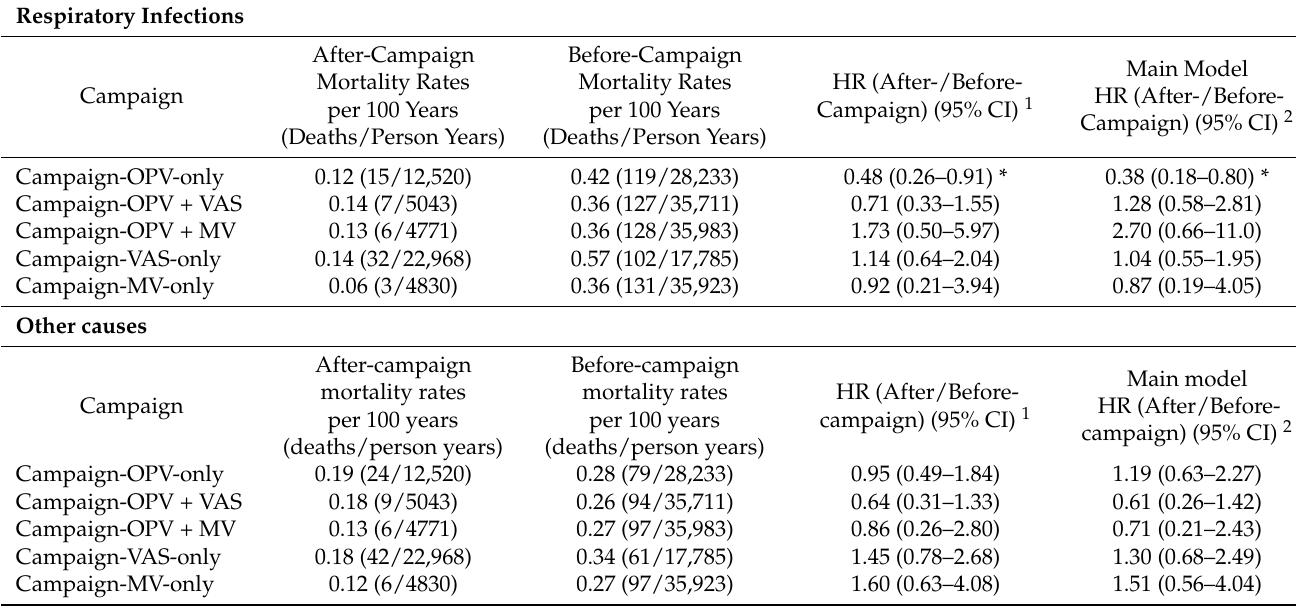
Table 1. Mortality rates (per 100 person-years) and hazard ratios (HR) for after-campaign vs. before-campaign for children only eligible for the oral polio vaccine (OPV) by cause of death. Analysis from 29 days to 35 months of age among children within the Chakaria HDSS from 2012 to